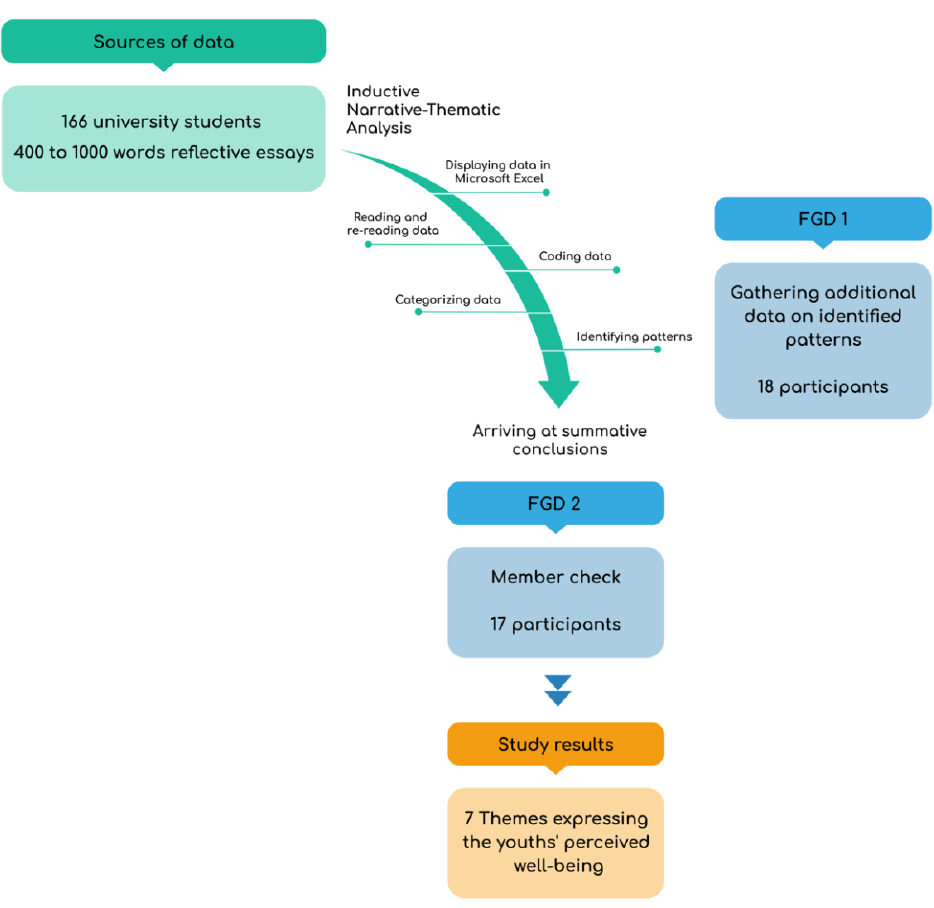
Figure 2. Research Figure 2. Research procedures.